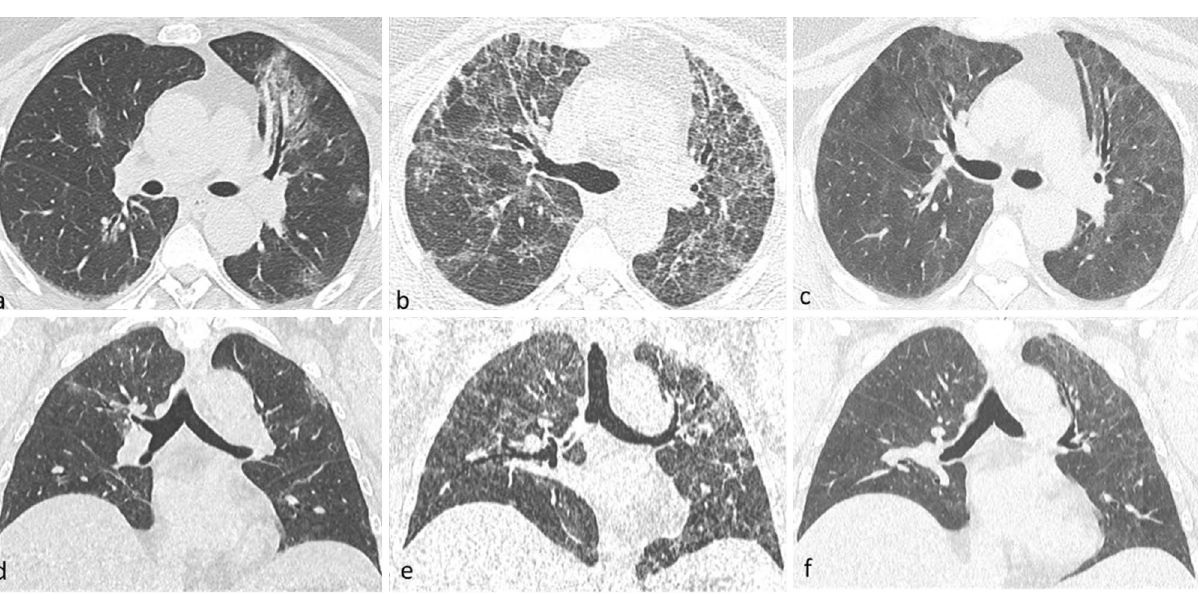
Figure 3. Disease evolution pattern consistent with OP sequelae. Axial ( a – c ) and coronal ( d – f ) CT images showing patchy ground glass opacities at baseline ( a – d ), diffuse ground-glass opacities with septal thickening, and perilobular opacities at 2–3 months ( b – e ), and subtle diffuse ground-glass with no CT features of lung fibrosis at 6–7 months ( c – f